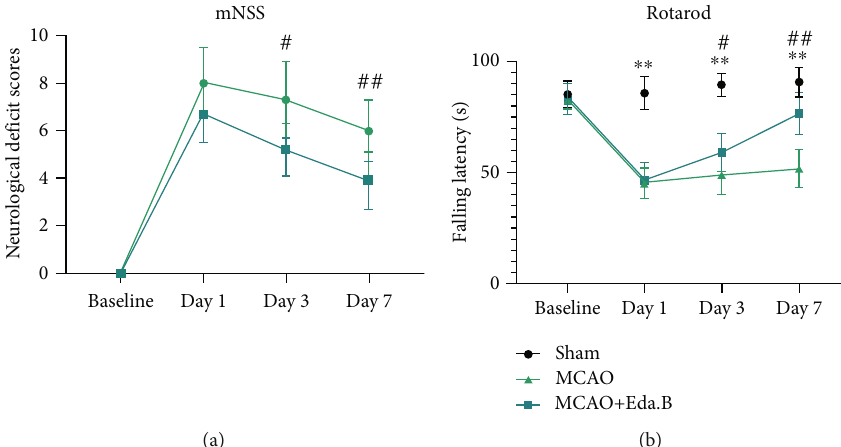
Figure 2: Eda.B improved neurological recovery in ischemic mice. (a) The mNSS evaluation at baseline and days 1, 3, and 7 after MCAO. (b) Rotarod test evaluation in Sham group, MCAO group, and Eda.B group at baseline and days 1, 3, and 7 after MCAO. ∗∗ P < 0 : 01 (MCAO group vs. Sham group), # P < 0 : 05 (Eda.B group vs. MCAO group), and ## P < 0 : 01 (Eda.B group vs. MCAO group), n = 10 in each